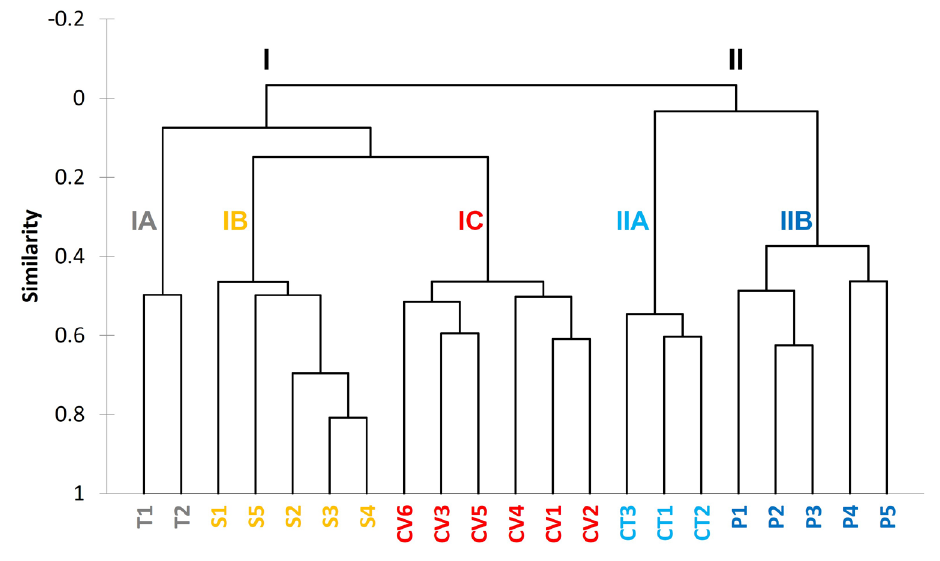
Figure 3. Dendrogram of the agglomerative hierarchical clustering of the vegetation relevés